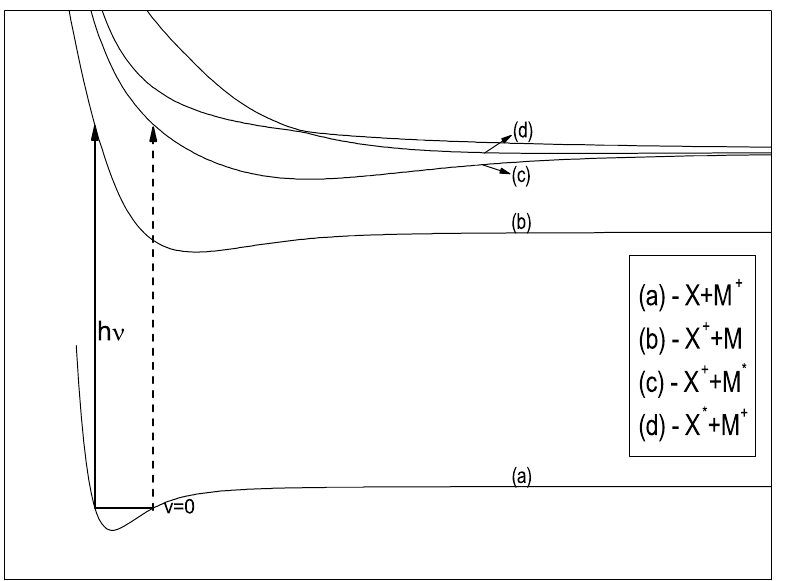
Figure 1. X and M denote atoms in the ground state, X ∗ and M ∗ —atoms in the first excited state and X + and M + —atomic ions. Solid arrow: The molecular-ion MX + in the ground state ( a ) absorbs the photon and passes into the first excited electronic state ( b ) which decays into the ion X + and the M atom in the ground state. Dashed arrow: Molecular-ion MX + absorbs a photon and passes into one of the higher electronic states ( c , d ) and decays so that one of the atoms remains in the excited